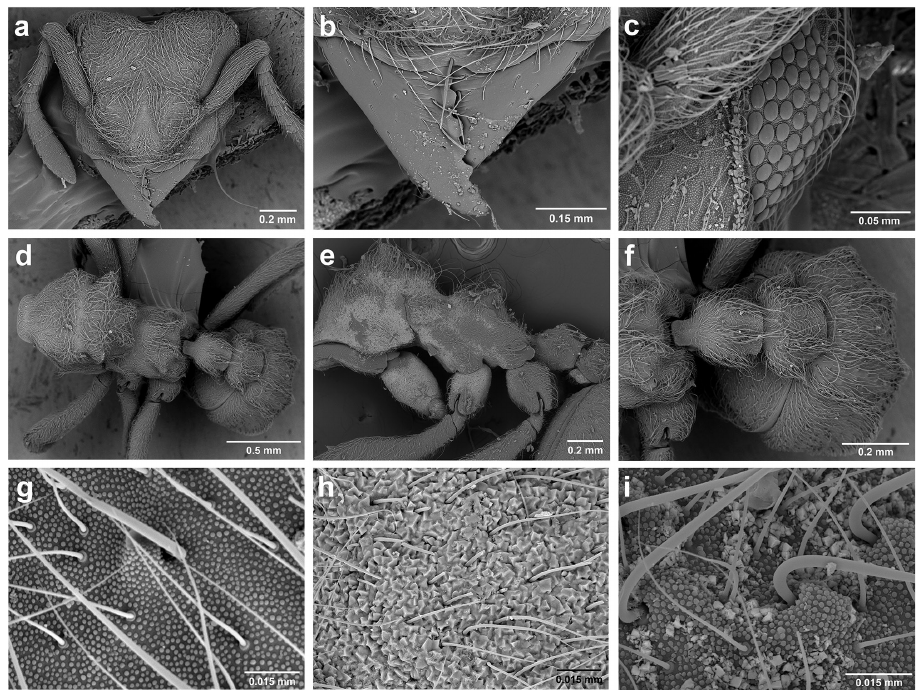
Figure 33. S. maravalhas worker (USNMENT00924090: ( a, b, c, d, f, g ) USNMENT01126226 ( e, h, i ), SEM images. a Head, full-face view b mandibles c eye d mesosoma and metasoma, dorsal view e meso- soma, lateral view f metasoma, dorsal view g head, papillate integument h mesosoma, integument with dense crystal-like layer i mesosoma, papillate integument with sparse crystal-like